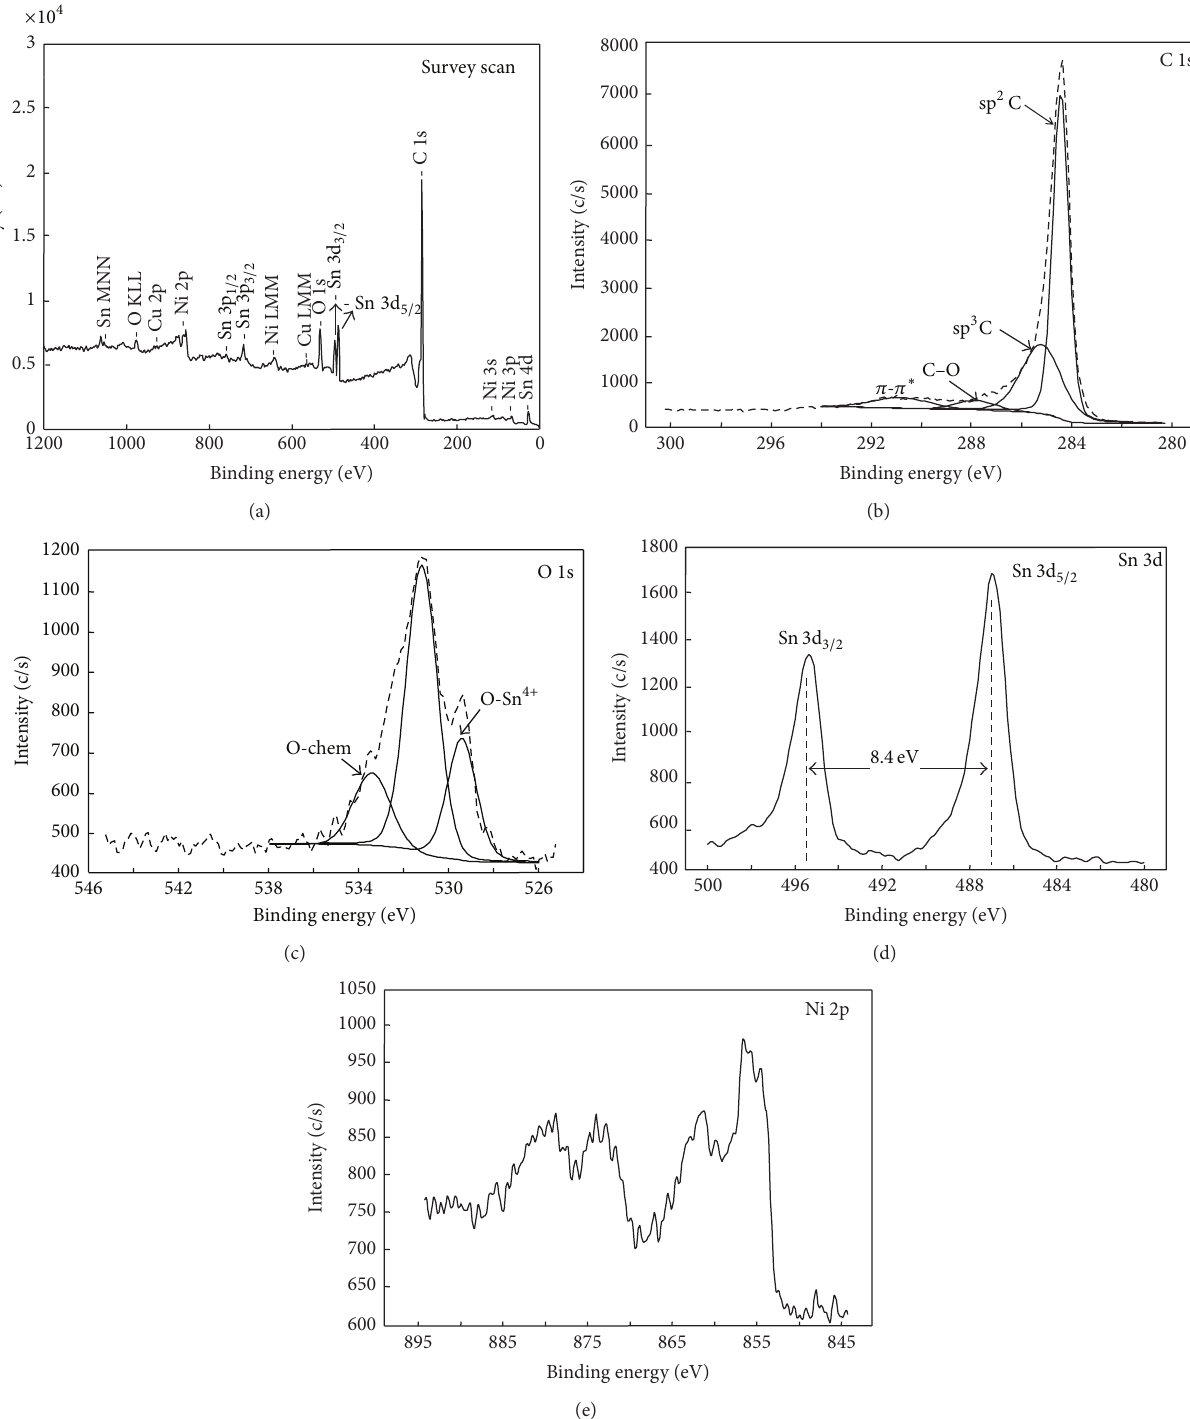
Figure 4: X-ray photoelectron spectroscopy spectrum of SnO 2 -CNT composites: (a) survey scan; (b)–(e) deconvoluted spectra for (b) C 1s, (c) O 1s, (d) Sn 3d, and (e) Ni 2p. Experimental data are represented by dashed lines ( --- ) and components contribution is represented by continuous